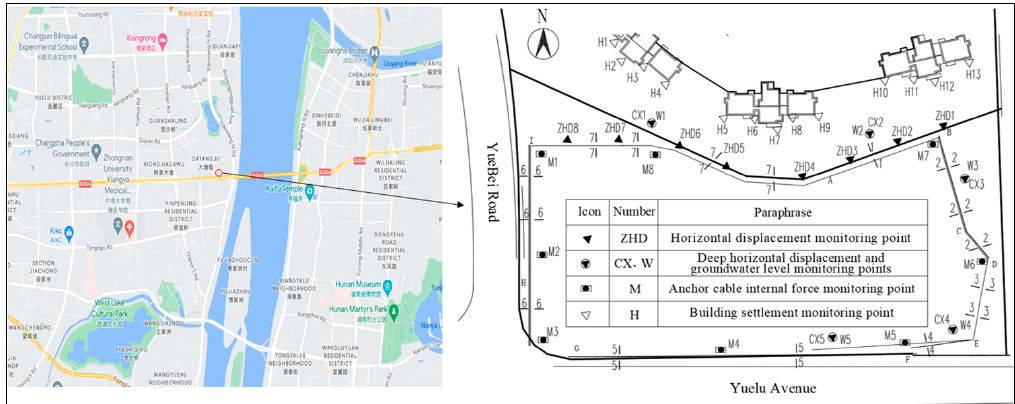
Figure 1. Location of foundation pit. Table 1. Physical and mechanical characteristics of soil samples.